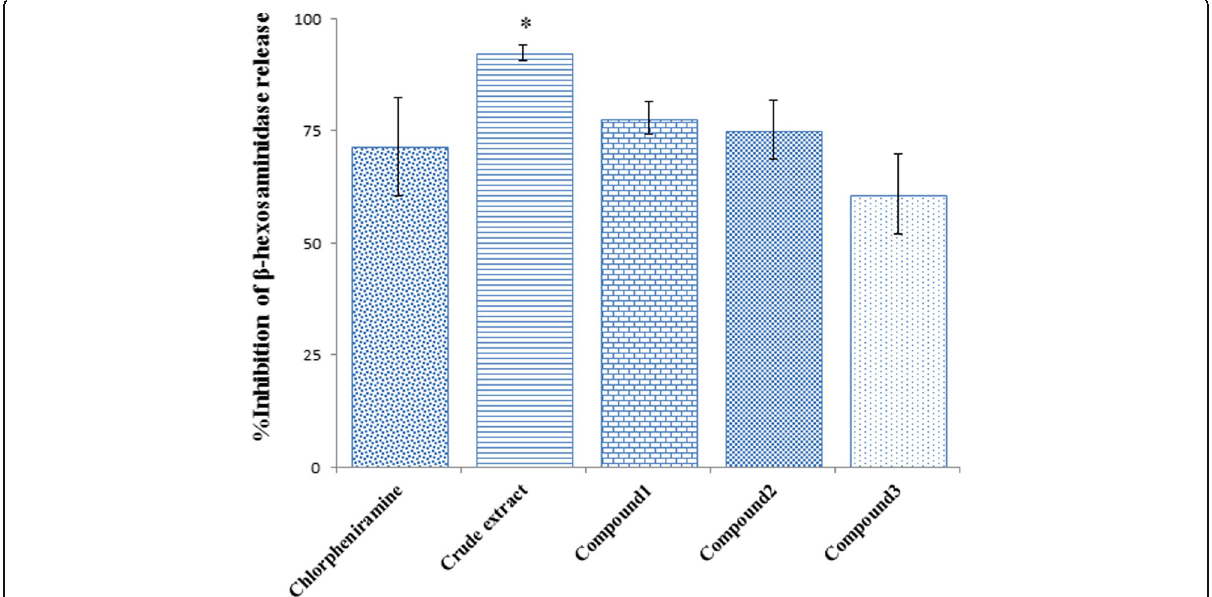
Fig. 2 Effect of ethanolic extract of B. montanum root and the isolated propiophenones at concentration of 50 μ g/mL on β -hexosaminidase release from RBL-2H3 cells. Results are present as mean±SD from triplicate experiment. Mean differences between sample and positive control were analyzed by student ’ s t-test. *Significant difference comparing tested sample and positive control analyzed by Student ’ s t-test ( p -value